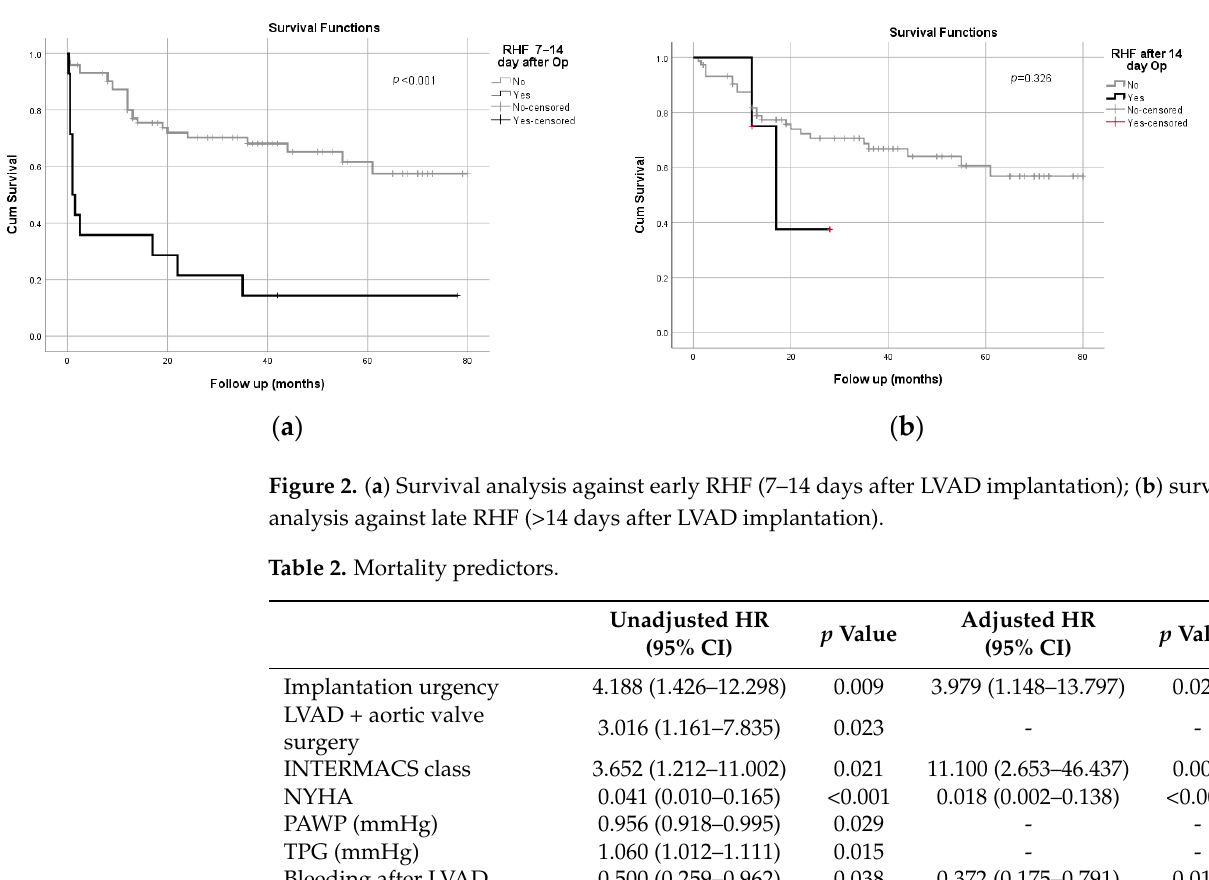
Table 2. Mortality predictors.